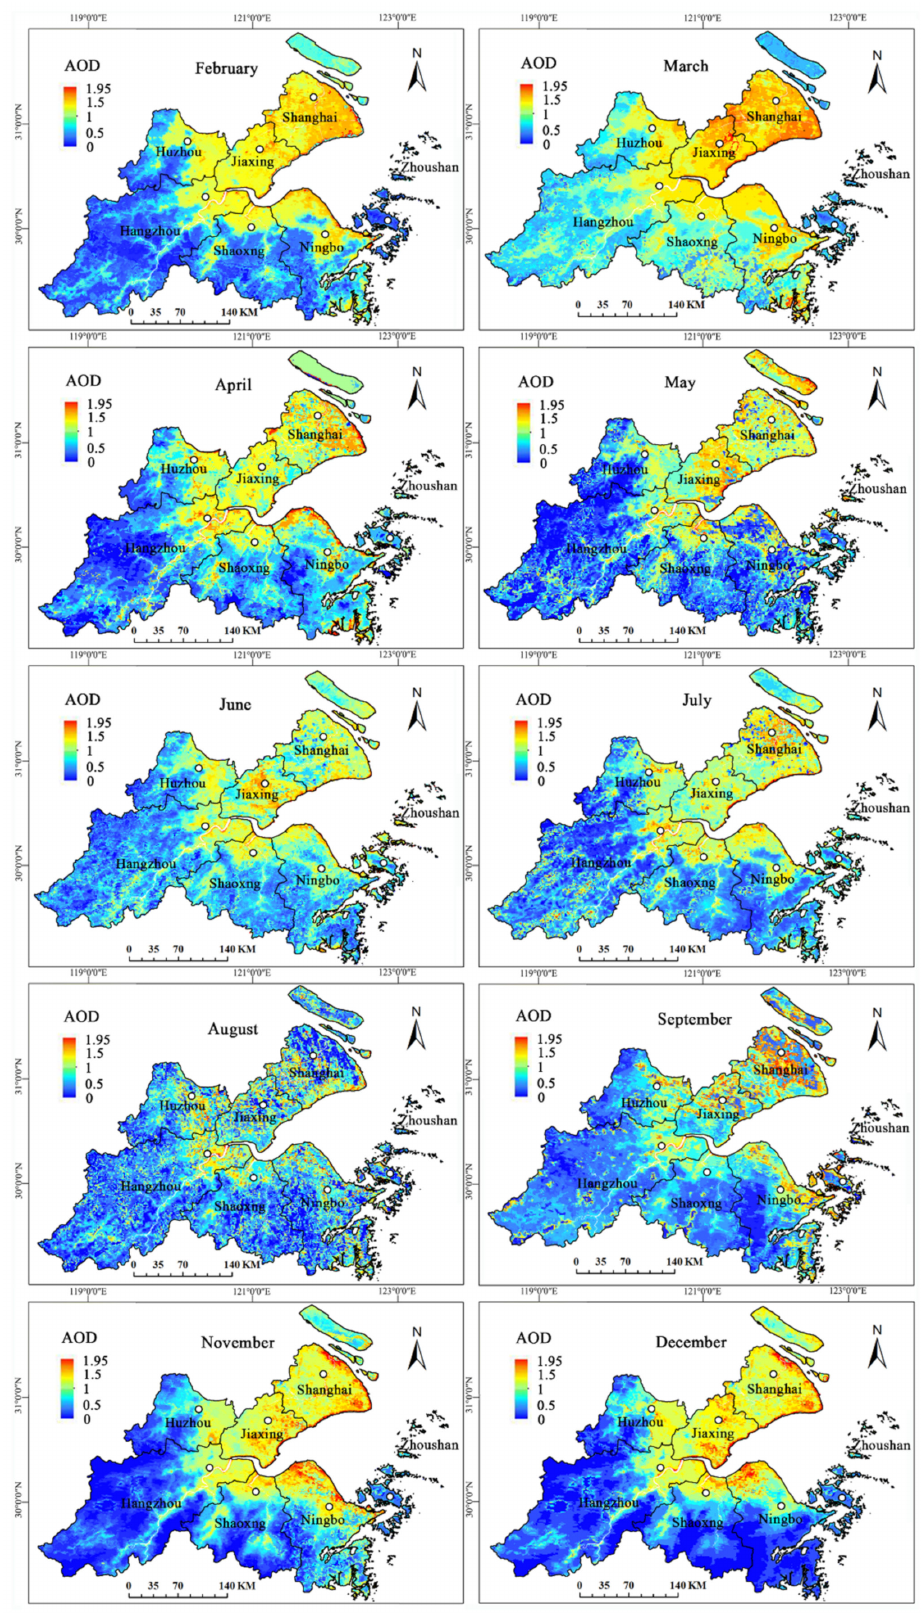
Figure 3. Monthly inversion AODs in